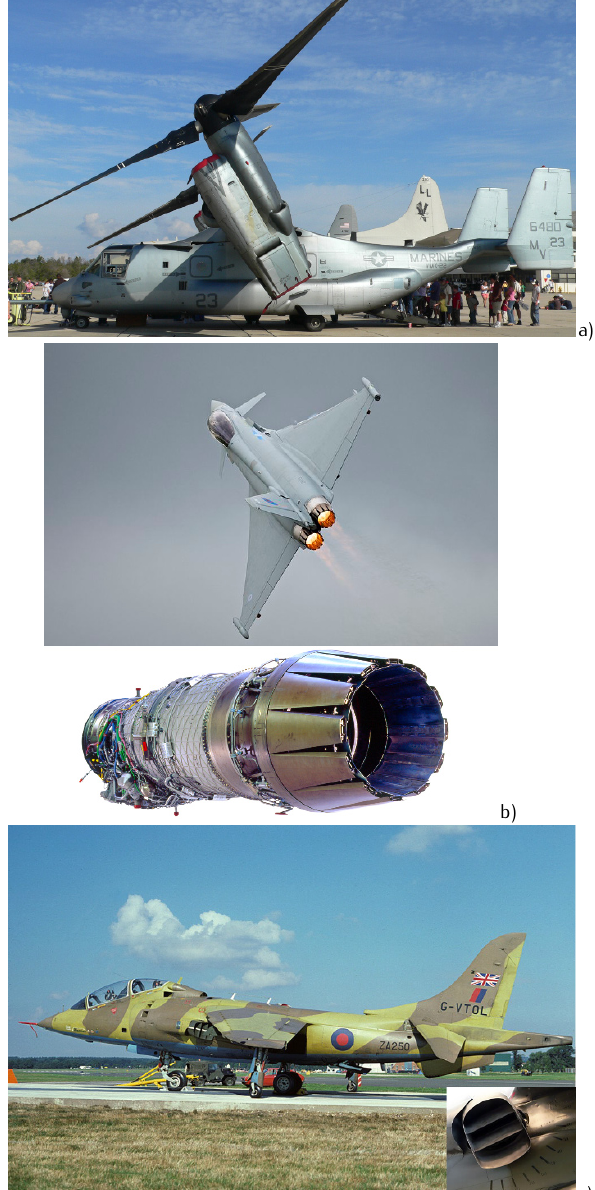
Figure 1. Examples of thrust vectoring technology in use today. a) The Bell-Boeing V-22 Osprey using a tilting rotor con- cept (source: obtained at NAS Pensacola). b) The mod- ern EJ200 engine system, installed in the Eurofighter Ty- phoon aircraf (source: under permission of EUROJET Turbo GmbH). c) Harrier fighter, including the detail of